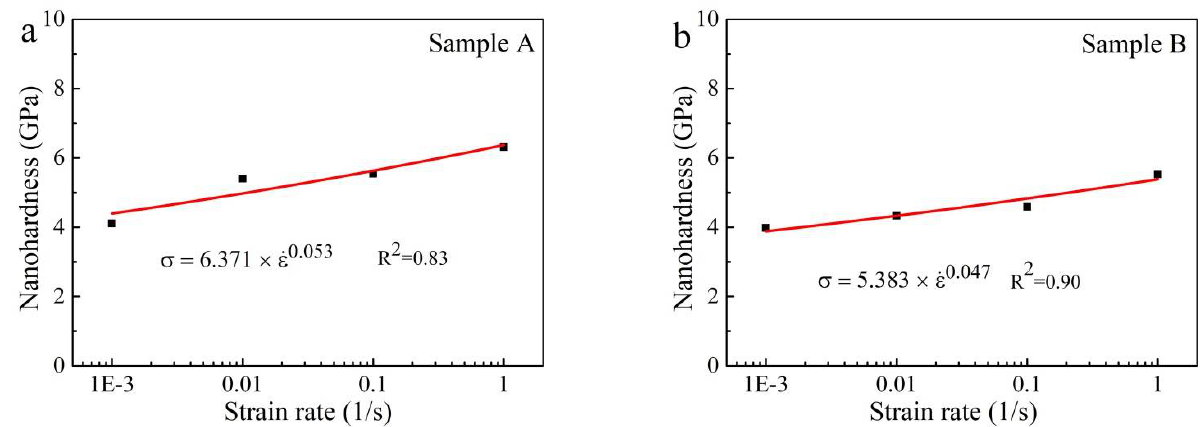
Figure 8. Representative nanohardness as a function of strain rate: ( a ) Linear scanning strategy (sample A) and the slope